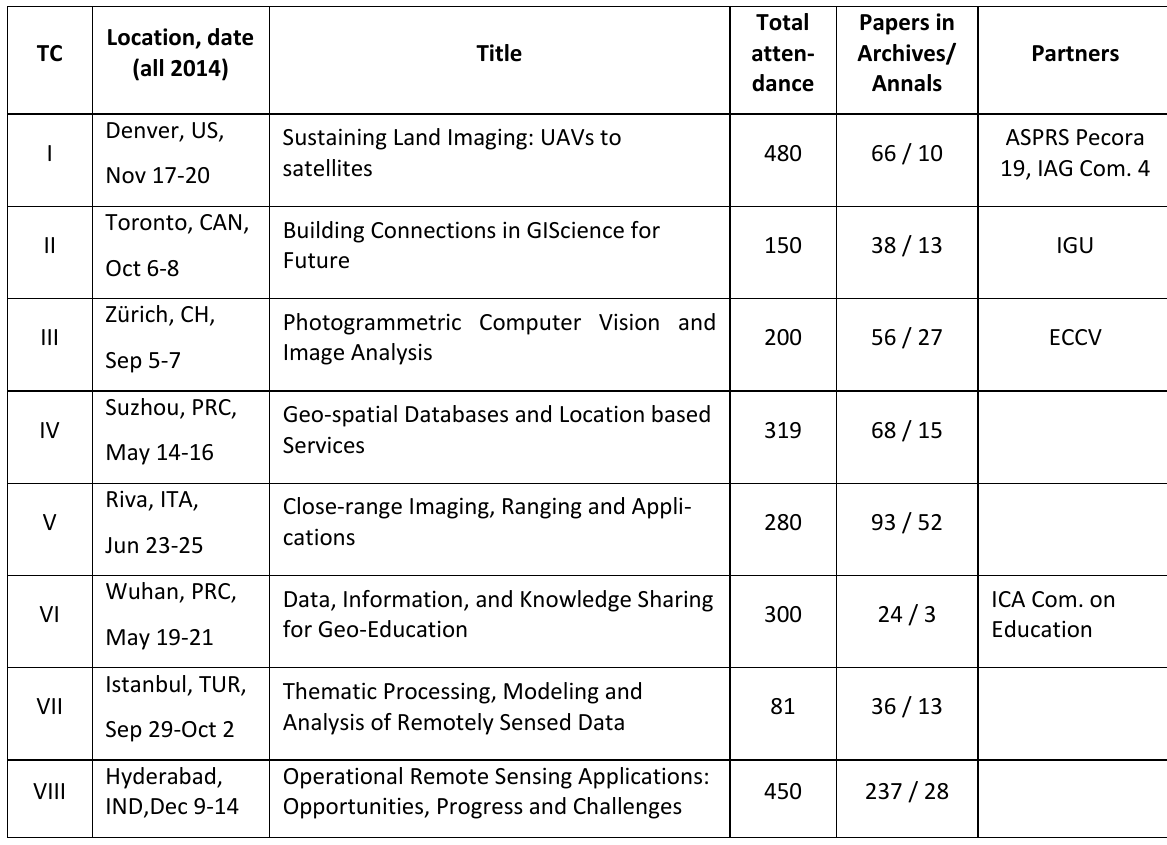
Table 1: ISPRS Technical Commission Symposia